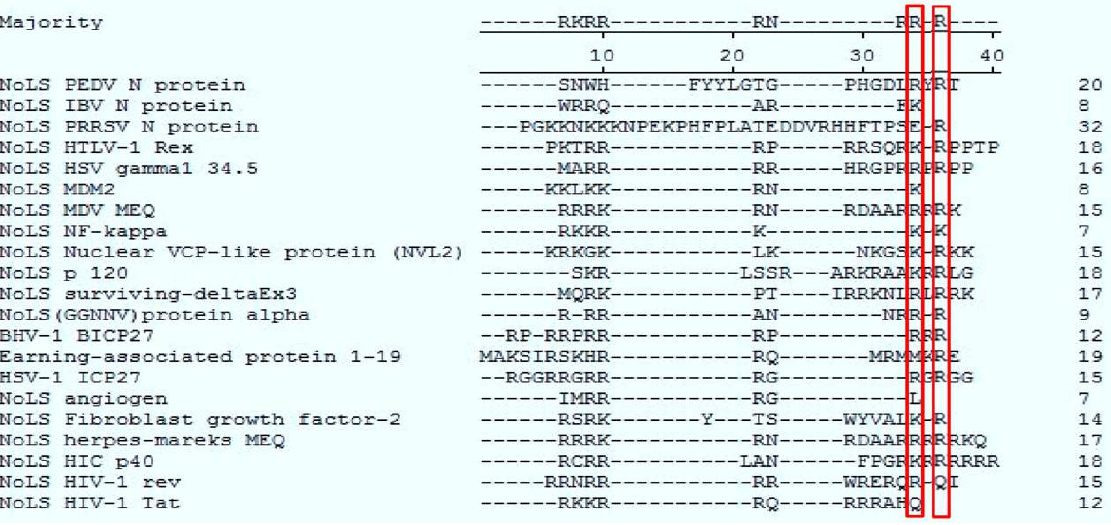
Figure 6. Clustal W analysis of the PEDV N protein NoLS with known cellular and viral NoLSs. Red squares indicate the amino acids of conservation. The cellular and viral NoLSs are described in NoLS IBV N protein [34], NoLS PRRSV N [20], NoLS HTLV-1 Rex [35], NoLS HSV gamma1 34.5 [36], NoLS MDM2 [37], NoLS MDV MEQ [38], NoLS NF-kappa [39], NoLS Nuclear VCP-like protein (NVL2) [40], NoLS p 120 [41], NoLS surviving-deltaEx3 [42], NoLS (GGNNV) protein alpha [43], BHV-1 BICP27 [44], Earning-associated protein 1–19 [45], HSV-1 ICP27 [46], NoLS angiogen [47], NoLS Fibroblast growth factor-2 [48], NoLS herpes-mareks MEQ [38], NoLS HIC p40 [49], NoLS HIV-1 rev [50], NoLS HIV-1 Tat